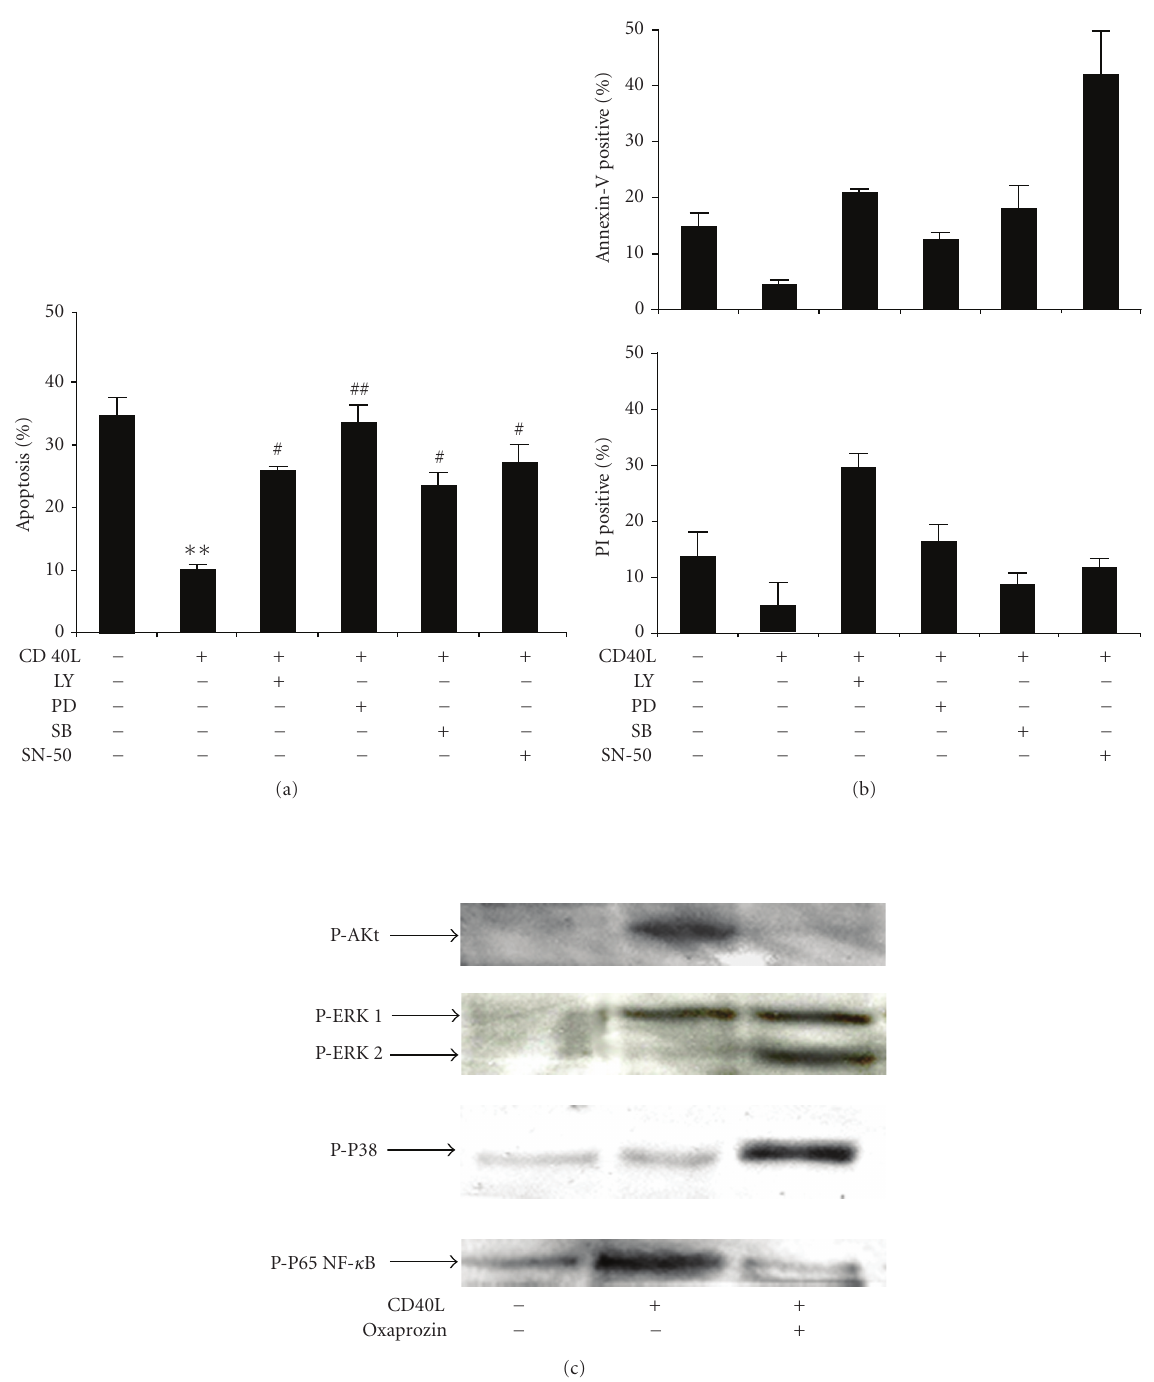
Figure 3: Oxaprozin-induced apoptosis involves the inhibition of CD40L-induced Akt and NF - κB phosphorylation . Monocytes were incubated for 48 hours with control medium or 200ng/mL CD40L plus 1 μ g/mL CD40L enhancer in the presence or absence of 50 μ M LY294002 (LY), 50 μ M PD98059 (PD), 1 μ M SB203580 (SB), or 20 μ M SN-50. (a) Assessment of apoptosis on cytopreps stained with acridine orange. Data are expressed as percentages of apoptotic cells on total number of cells counted (mean ± SEM, n = 3, apoptosis in absence versus in presence of CD40L: ∗∗ P < .01; apoptosis in presence of CD40L versus CD40L plus PD: ## P < .01; apoptosis in presence of CD40L versus CD40L plus LY or SB or SN-50: # P < .05). (b) Assessment of apoptosis using Annexin V and Propidium Iodide (PI) binding assay. Data are expressed as percentages of positive cells on total number of cells counted (mean ± SEM, n = 2). (c) Monocytes were prencubated in the presence or absence of 100 μ M oxaprozin for 1 hour and then stimulated with control medium or 200ng/mL CD40L plus 1 μ g/mL CD40L enhancer for 15 minutes. Then, cells were lysed, and western blot analysis was performed. Results represent one of three experiments that yielded similar